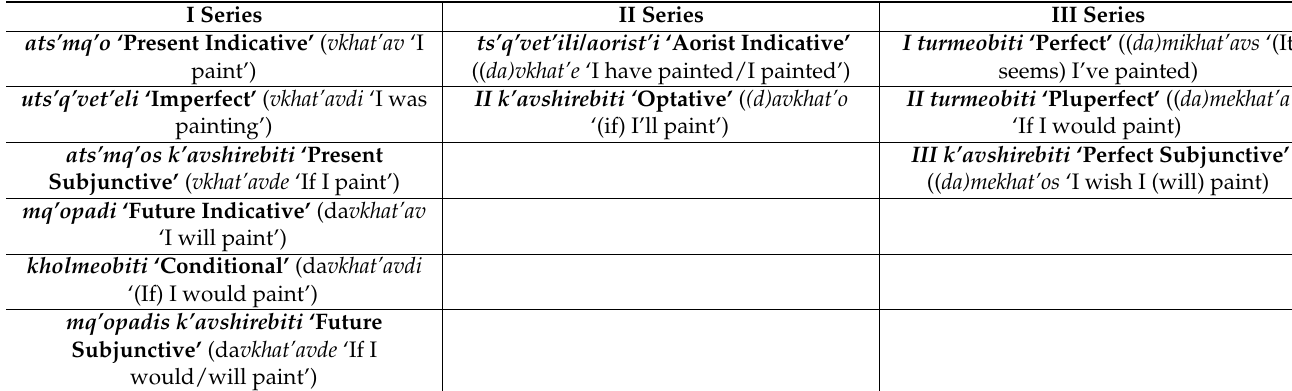
Table 5. Series and screeves of Georgian verbs.